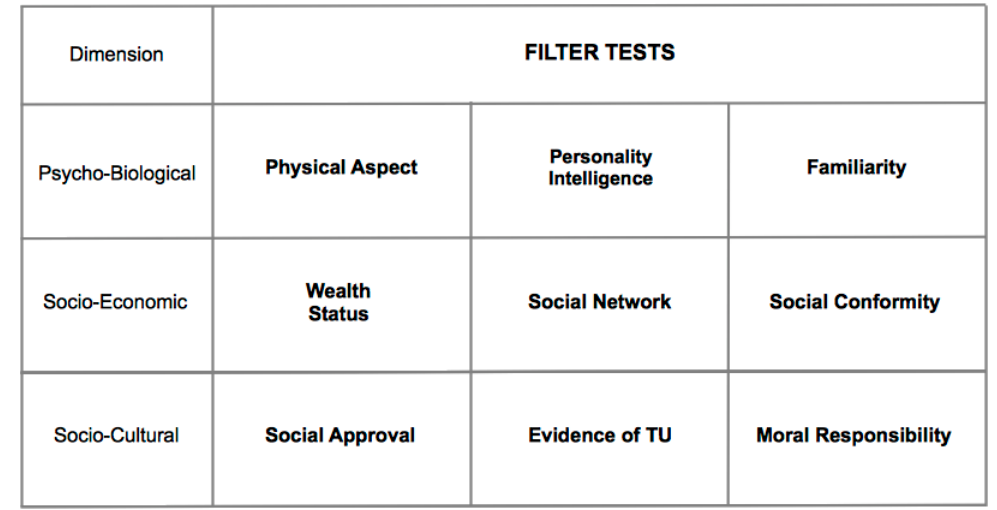
Figure 3. Different categories of Filter Tests.